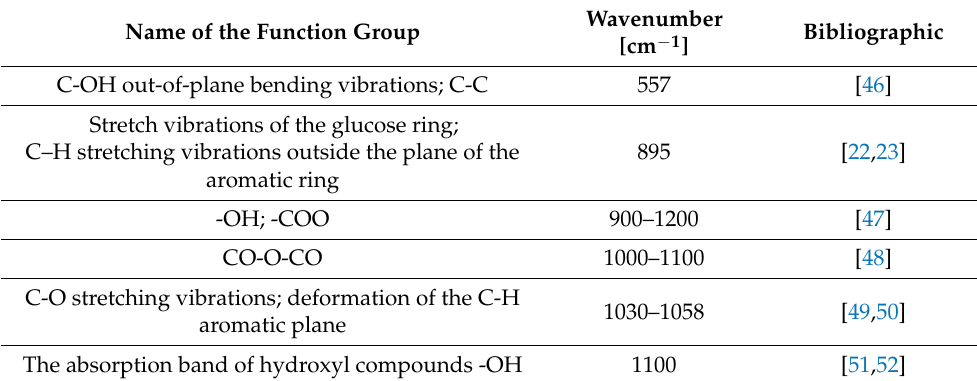
Table 1. Absorption signals of Fourier transform infrared spectroscopy for the spectrum of hemp